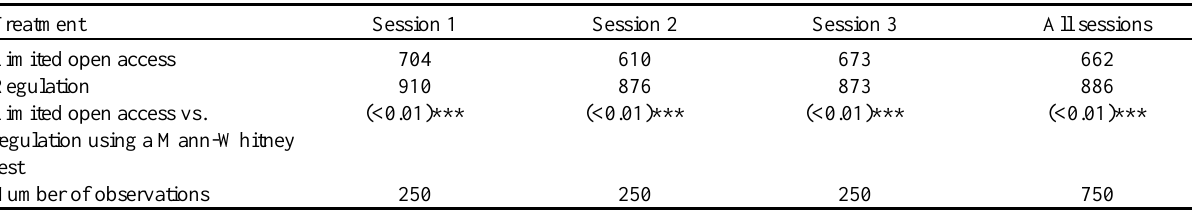
Table 4 . Average earnings under limited open access and regulation Treatment Session 1 Limited open access Regulation Limited open access